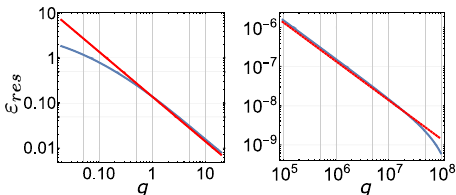
Fig. 7 Residual energy for the exactly solvable exponential spectral density. Blue solid line: residual energy in equation (50) at various scales. The parameters are fi xed at a = 1 and N ¼ 10 9 . To guide the eye, ~1/ g is plotted in red dotted lines.